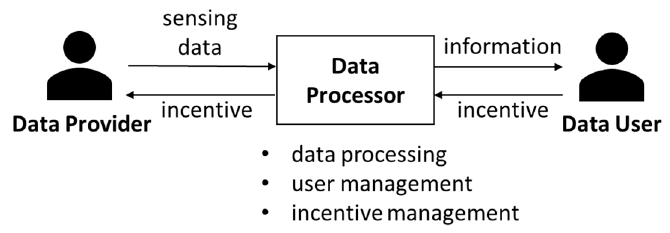
Figure 1. Crowdsensing system structure.